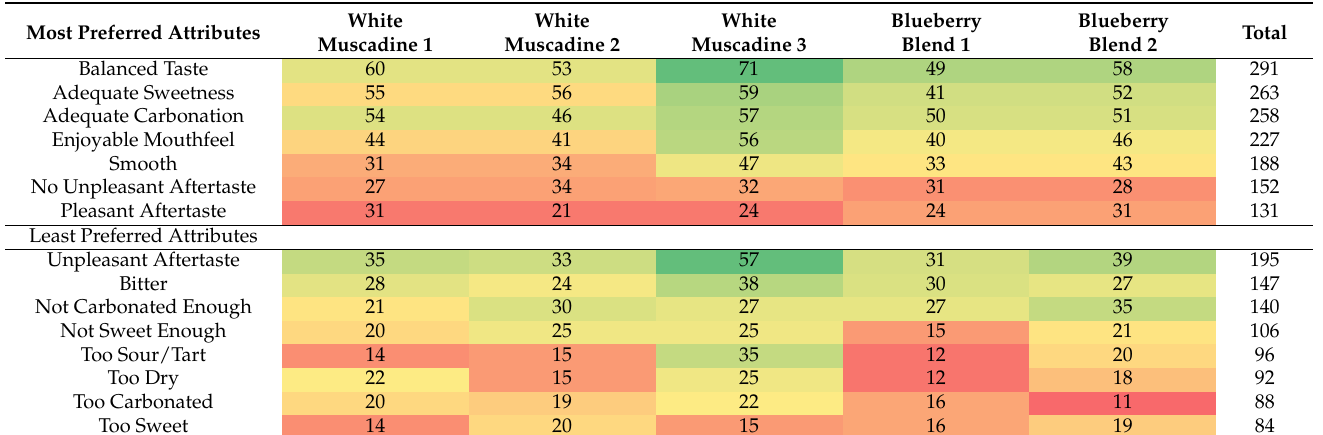
Table 2. Comments indicating attributes for the most preferred and least preferred sample from five Florida fruit and muscadine wines. A green–red heat map is used to indicate the highest number of participants selecting a comment (green) to the lowest